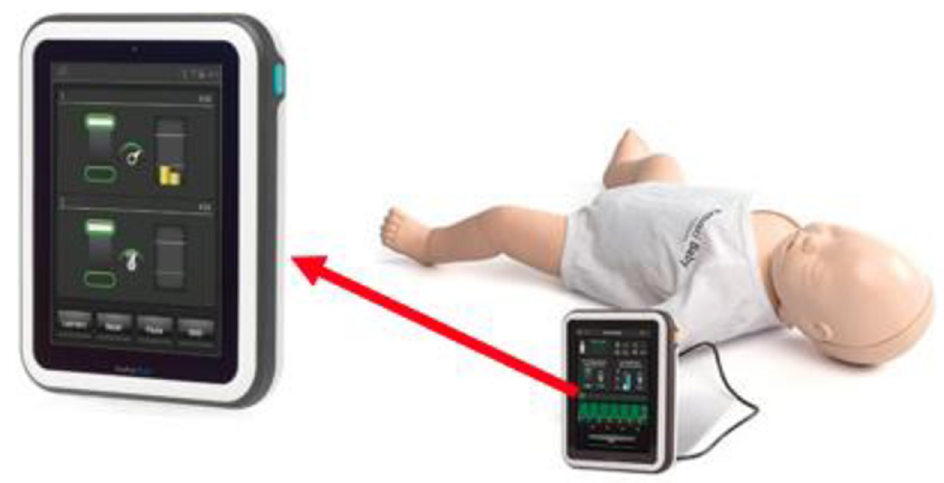
Fig 1. Term Laerdal Resusci 1 Baby QCPR manikin (Stavanger, Norway) and Laerdal SimPad PLUS with SkillReporter 1 206–30001 (Stavanger,